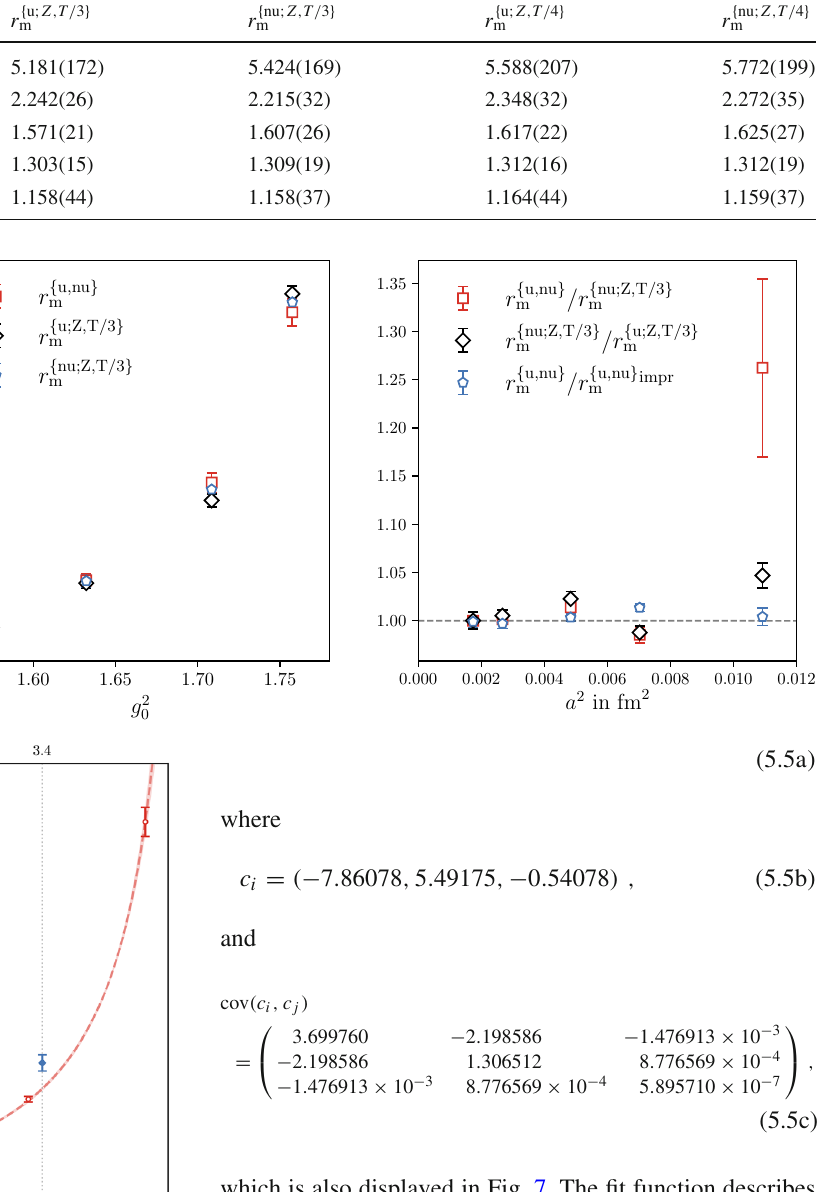
Table 4 Results for r m , obtained via Eqs. (5.2)–(5.4)